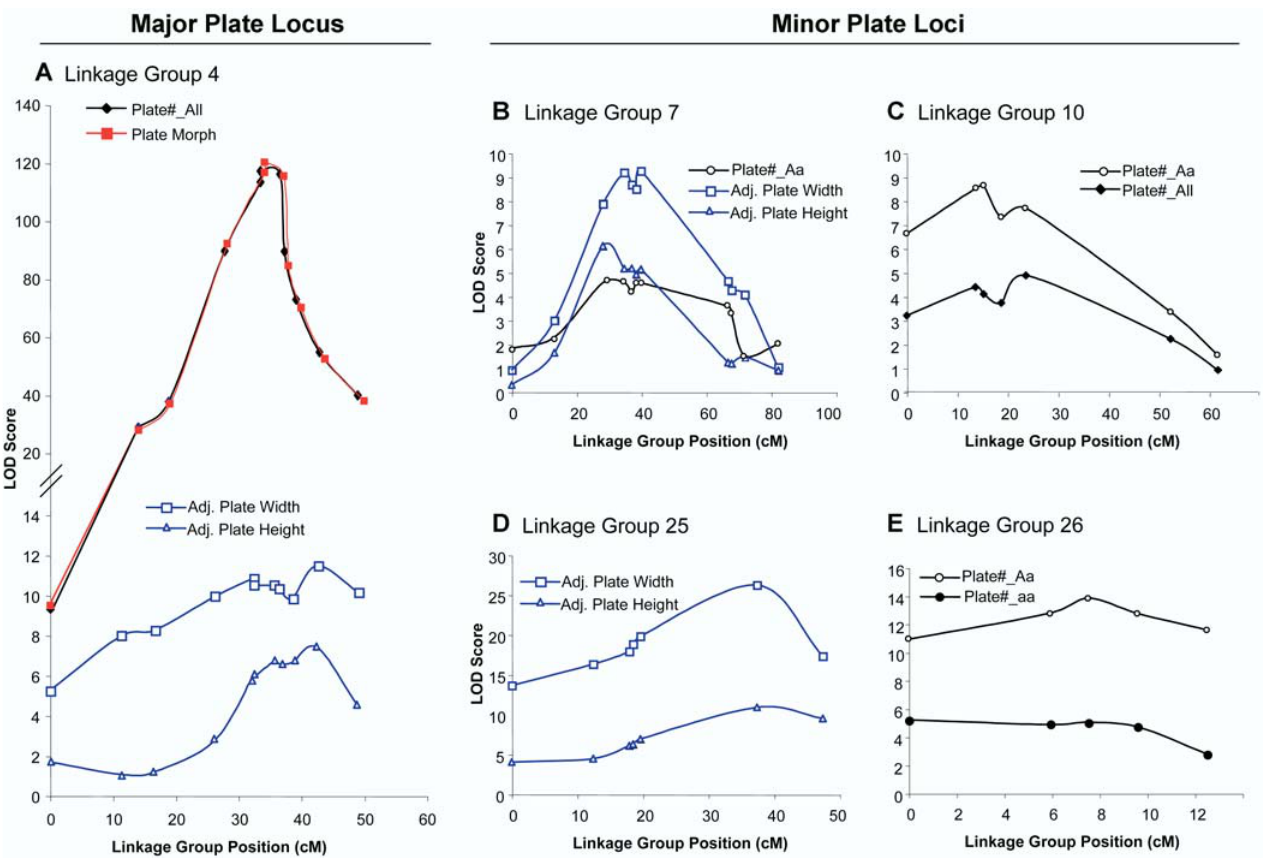
Figure 2. Comparison of QTL Positions for Different Traits LOD scores are shown as a function of genetic distance along different stickleback linkage groups. QTL affecting qualitative plate pattern (red line), total plate number (black lines), or plate size (blue lines) show similar shapes on several linkage groups, suggesting that the same or linked genes control multiple aspects of plate phenotype. Points in LOD plots correspond to the following microsatellite markers from left to right along each linkage group: (A) LG 4: Pitx2 (Stn220), Stn38, Gac62, Stn42, Gac4174, Stn45, Stn183, Stn46, Stn47, Stn184, Stn39; (B) LG 7: Stn70, Stn72, Stn76, Stn71, Stn78, Stn79, Stn75, Stn81, Stn80 Stn82, Pitx1; (C) LG 10 : Stn119, Stn120, Stn211, Stn121, Stn124, Stn23, Stn125; (D) LG 25: Stn212, Stn213, Stn214, Stn215, Stn216, Gac1125, Stn217; (E) LG 26: Stn218, Stn219, Bmp6, Stn222, Stn223 . Note that markers Stn183 and Stn184 from LG 18 in the Priest Lake cross (Peichel et al. 2001) map together with LG 4 markers in the larger Cross 1. DOI: